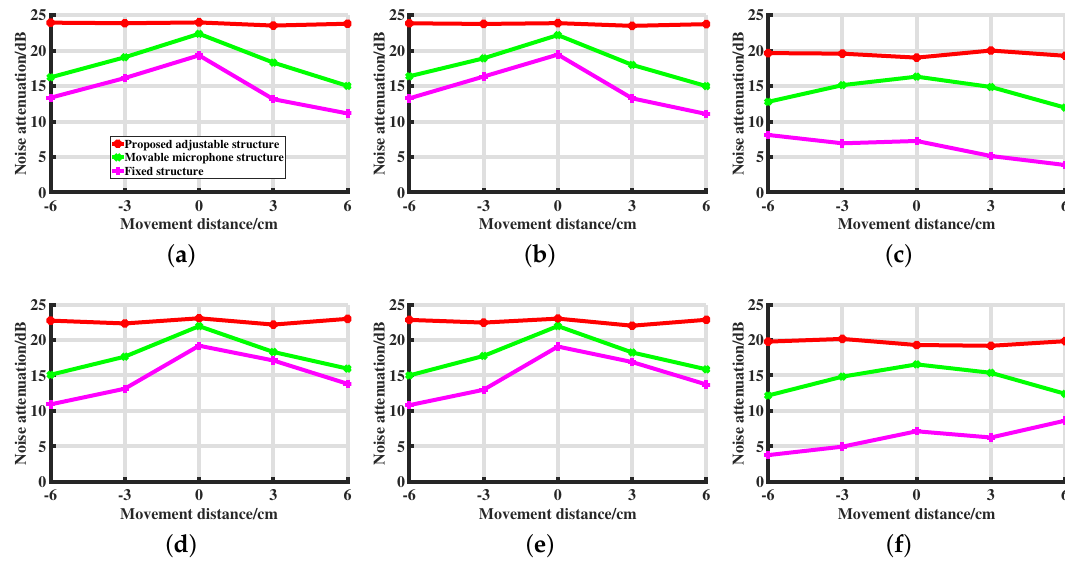
Figure 7. Noise attenuation (dB) at the ears as the dummy head moved in the x direction when employing various headrest structures and VS methods. ( a ) AFM, left ear. ( b ) RMM, left ear. ( c ) VMM, left ear. ( d ) AFM, right ear. ( e ) RMM, right ear. ( f ) VMM, right ear.